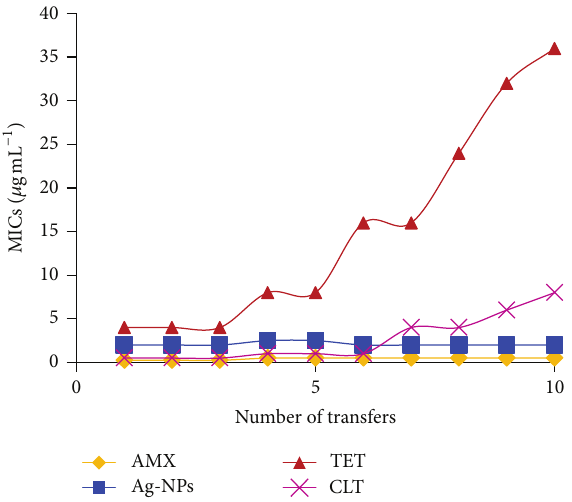
Figure 7: Resistance developments in H. pylori strain NCTC 11637 after repeated exposure to silver nanoparticles and standard